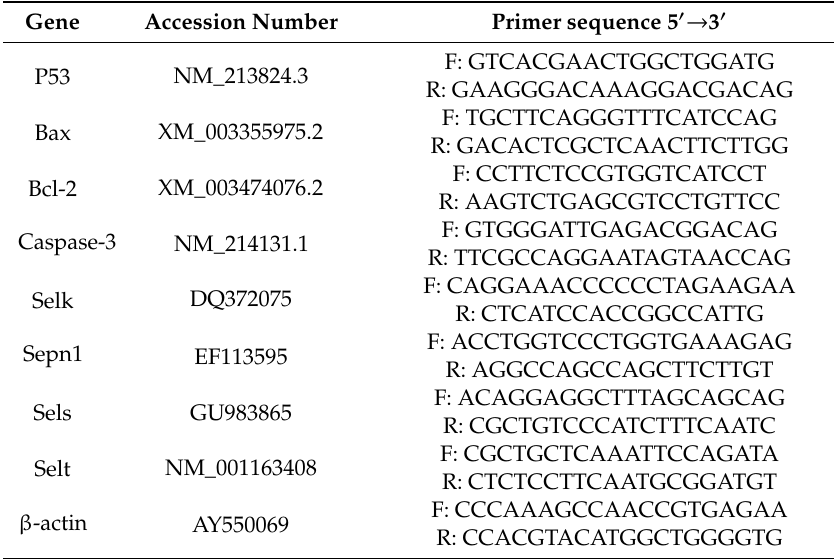
Table 2. Primer sets for